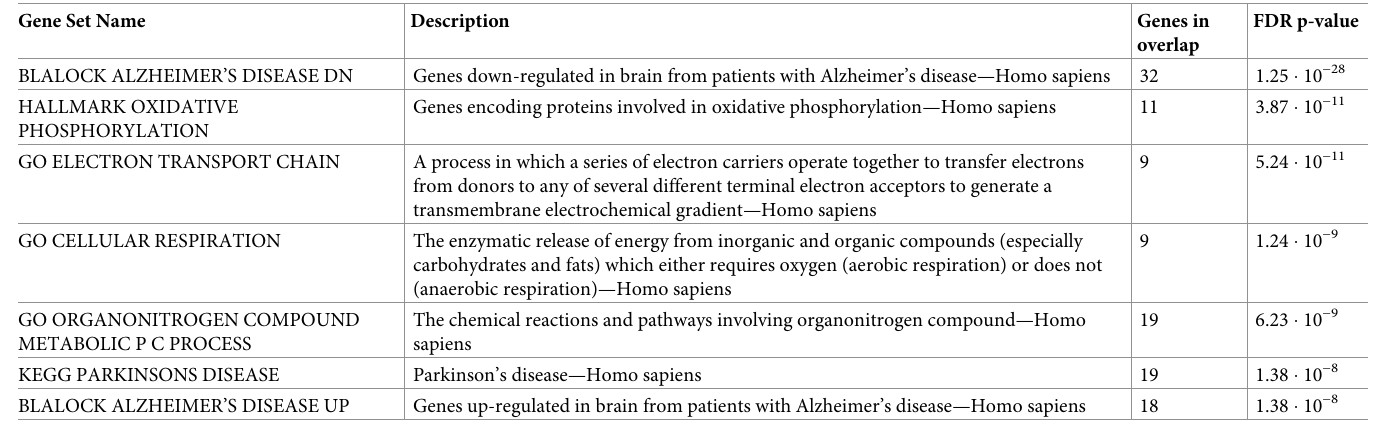
Table 2. Results of gene set enrichment analysis for C 1 community. In the third column overlaps with gene set in the selected MSigDB gene set collection are reported. The fourth column displays the false discovery rate (FDR) analog of hypergeometric p-value after correction for multiple hypothesis testing according to Benjamini and Hochberg [43]. The table shows seven most significant enrichments.